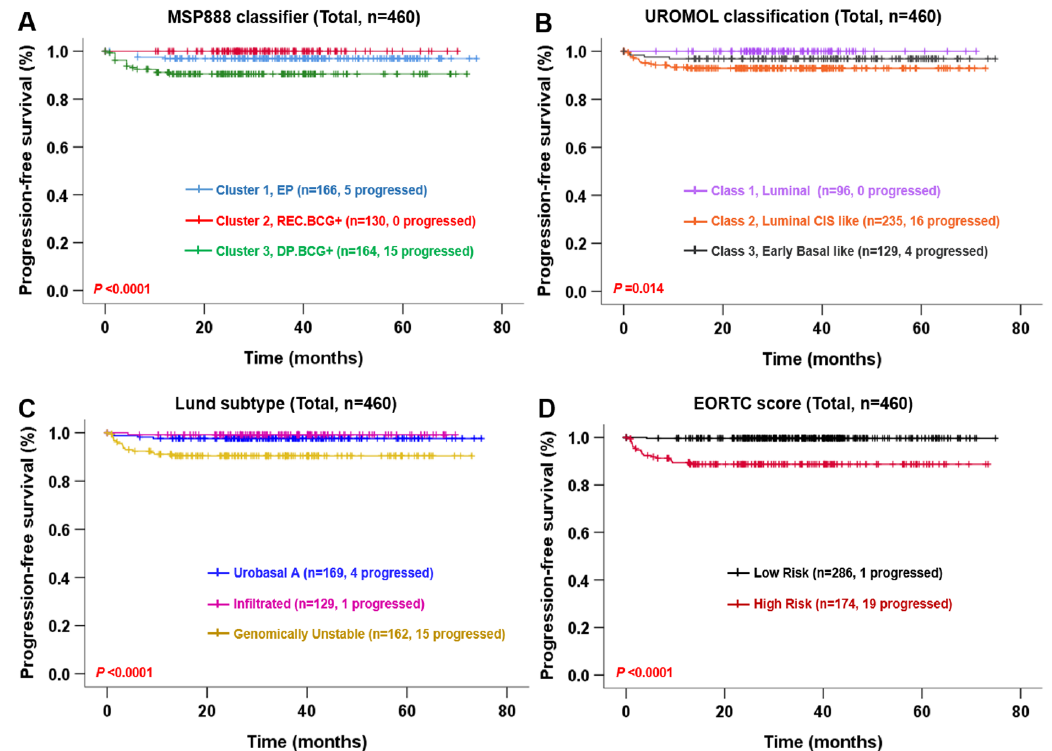
Figure 3. Kaplan–Meier survival curves showing risk of progression in the UROMOL cohort. Progression‑free survival according to MSP888 classifier ( A ), UROMOL classification ( B ), Lund sub‑ type ( C ) and EORTC risk score ( D ).